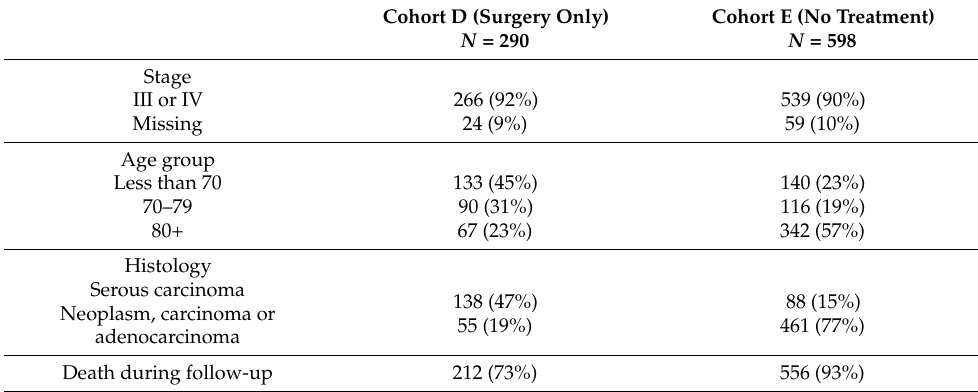
Table A6. Cohorts who did not receive systemic